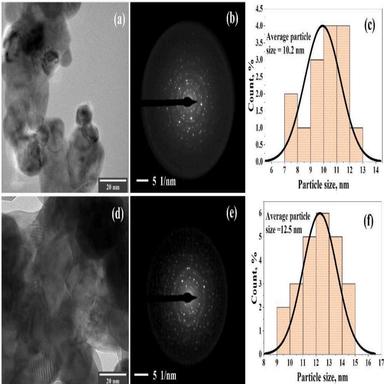
TEM images, electron diffraction patterns and particle size distribution analysis of the two BZO composite samples: (a, b and c) BZO-1 and (d, e and f) BZO-2.